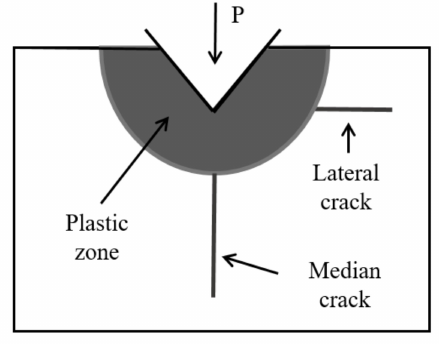
Figure 3. Micro-indentation